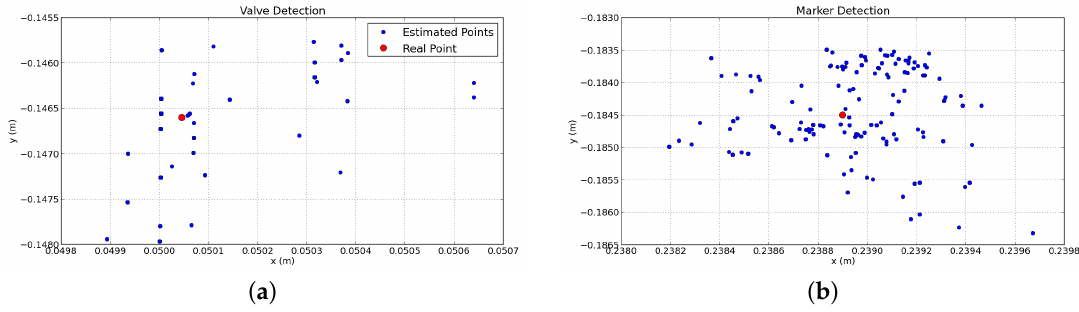
Figure 9. Valve detection ( a ) and AR Marker ( b ) estimations on the x / y